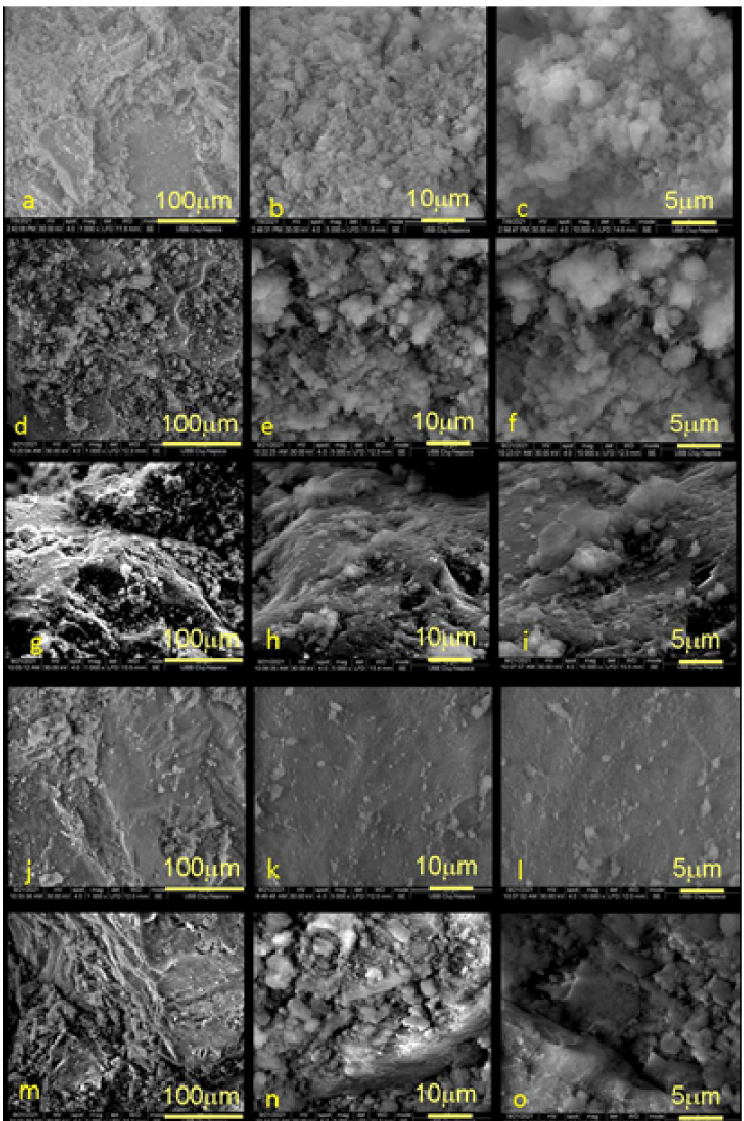
Figure 6. SEM images showing the morphology of the surfaces of the tested mortars: ( a – c ) Reference mortar (M); ( d – f ) M-1% GO; ( g – i ) M-5% GO; ( j – l ) M-GO-Ag-GO-Fly ash; ( m – o ) M-GO-ZnO-TiO 2